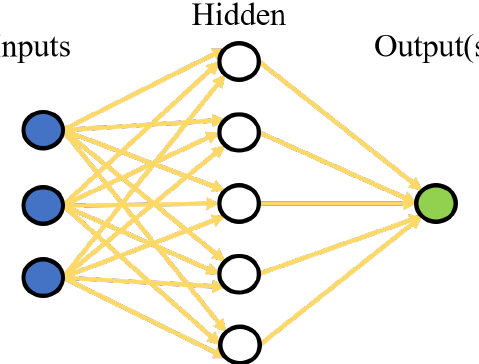
Figure 10. Artificial neural network structure.